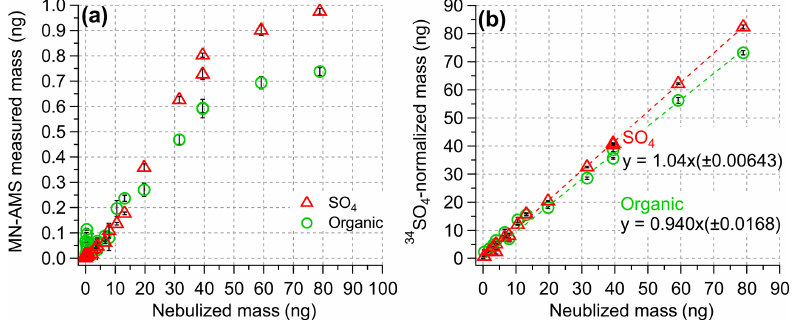
Figure 3. (a) The MN-AMS-measured mass of organics and SO 4 compared to the expected mass of sucrose and SO 4 . The ratio between the two values gives the nebulization efficiency of each component. The MN-AMS measured mass is not linearly proportional to the nebulized mass, but this can be corrected with internal standardization (as in panel b ). (b) The 34 SO 4 -normalized mass of organics and SO 4 compared to the nebulized